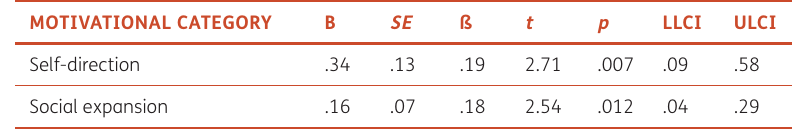
Table 3c Stepwise regression predicting willingness to participate in additional volunteering activities, sample 3. R 2 = .092; F (2, 219) = 11.08, p <